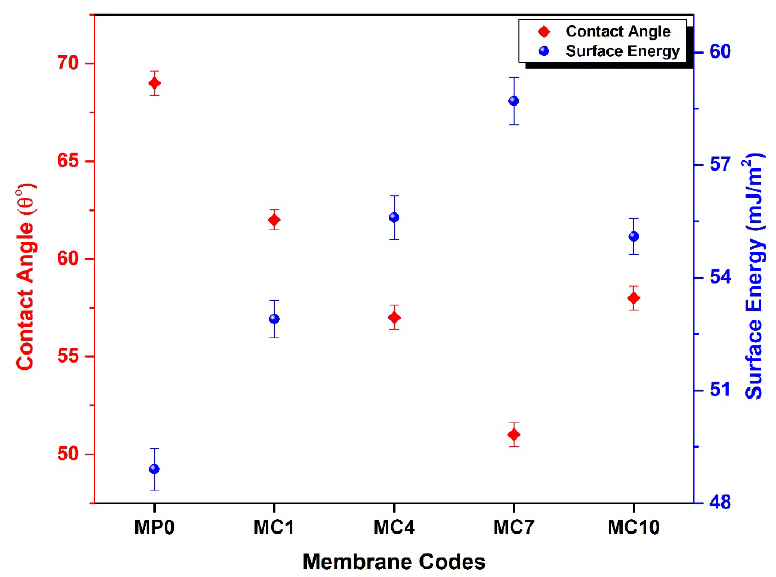
Figure 11. The contact angle of pristine PES membrane and mAC incorporated PES membranes. Sample codes are summarized in Table